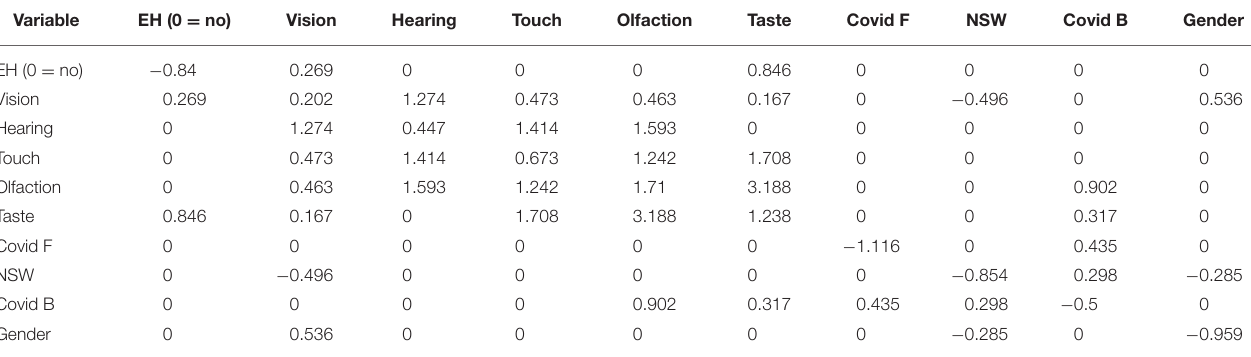
TABLE 2 | The matrix reports the network weights, which corresponds to a regularized odd ratio.